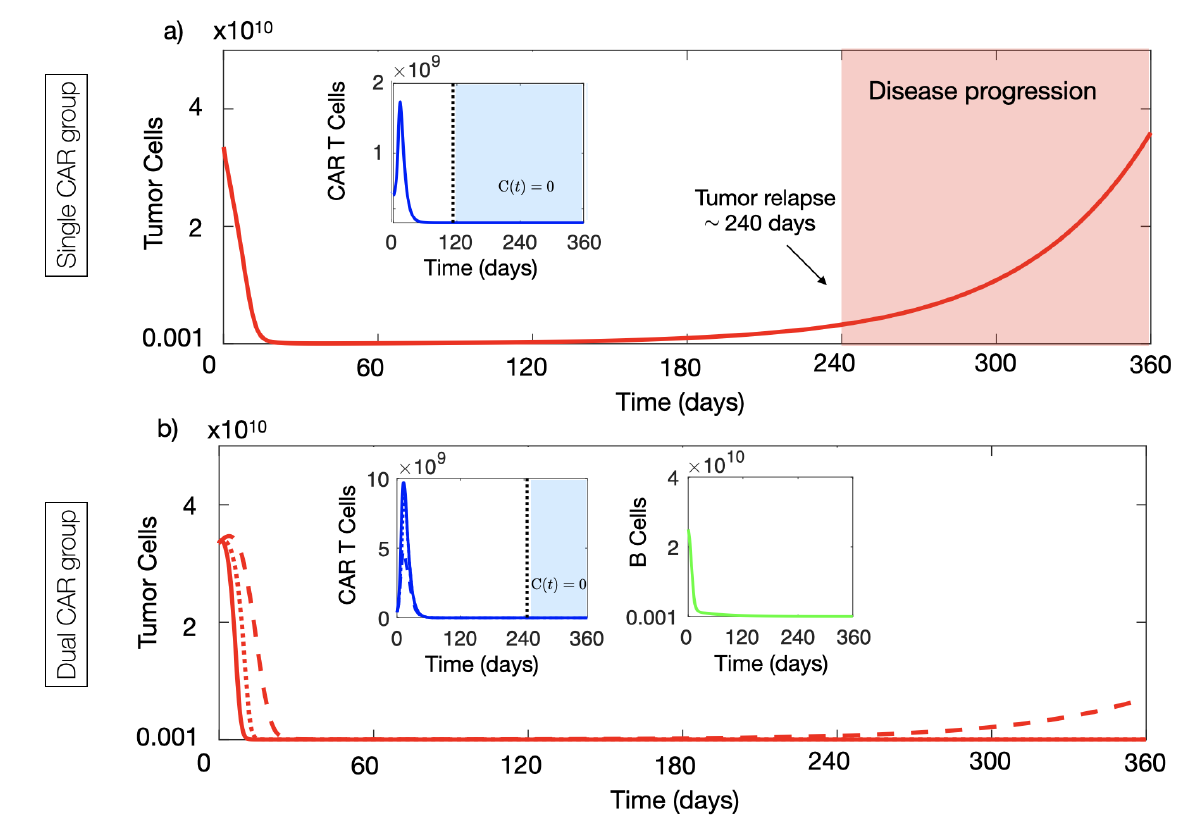
Figure 5. Long-term dynamics of virtual patients. ( a ) Dynamics of the number of CAR-T (blue curve) and tumour cells (red curve) governed by Equations (1) and (2). Initial conditions and tumour inactivation rate used in the simulation were C 0 = 4 × 10 8 , T 0 = 3.35 × 10 10 and α 1 = 0.01 day − 1 . ( b ) Dynamics of the number of CAR-T cells (blue curves), B cells (green curve) and tumour cells (red curve) ruled by Equations (3)–(6) in three different scenarios of immune suppression: α 1 = 0.04 day − 1 (solid lines), α 1 = 0.07 day − 1 (dotted lines) and α 1 = 0.2 day − 1 (dashed lines). Initial conditions used in the simulation were ¯ C 0 = 2 × 10 8 , C 0 = 0, B 0 = 2.5 × 10 10 and T 0 = 3.35 × 10 10 cells. Parameter values used in the simulations were τ C = 7 days, ρ ¯ C = ρ C = 0.9 day − 1 , ρ T = 1/50 day − 1 , α 2 = 2.5 × 10 − 10 day − 1 cell − 1 , g T = 10 10 cells, g C = 2 × 10 9 cells, g B = 10 10 cells, k = 0.2, α B = 4.5 × 10 − 11 day − 1 cell − 1 and τ B = 60 day − 1